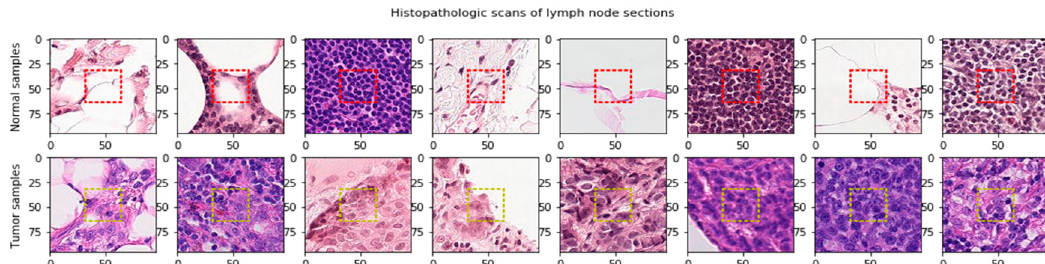
Figure 3. Lymph node sections extracted from digital histopathological microscopic scans. The significant features determine the cancer cells are in the center area (32 × 32). Red dash lines define the center region in the normal samples. Yellow dash lines define the center region in the tumor samples.